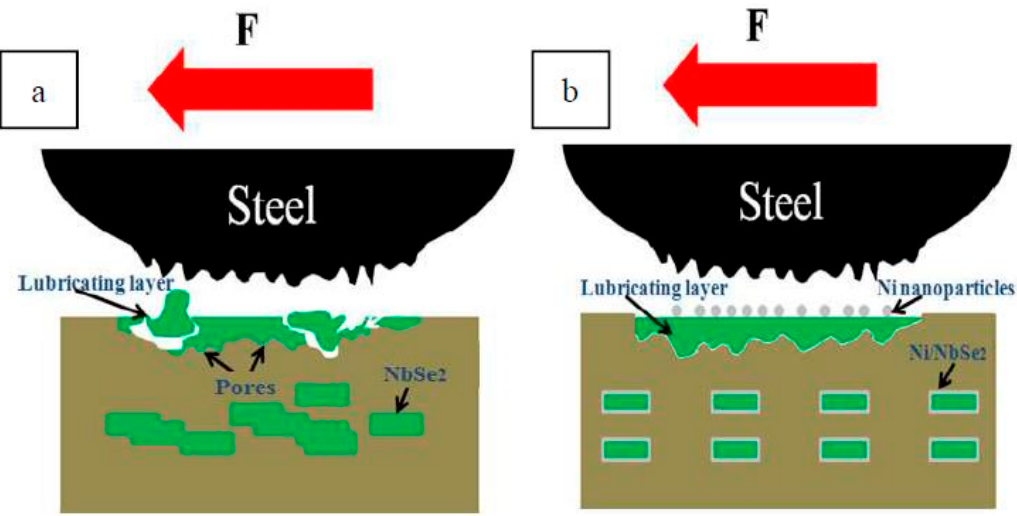
Figure 8. Anti-friction and wear-resistance mechanism of Cu-based composites ( a ) Cu / NbSe 2 , ( b ) Cu / Ni / NbSe 2.